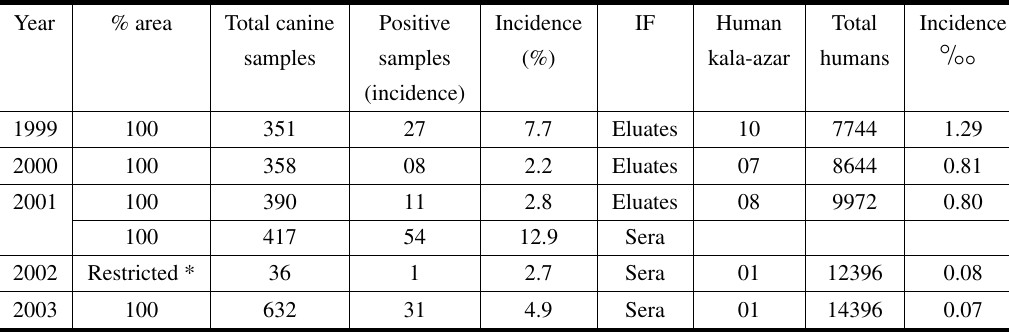
Effect of the use of immunofluorescency in blood eluates or sera samples for the epidemiological control of ZVL in Jardim Progresso, Natal,